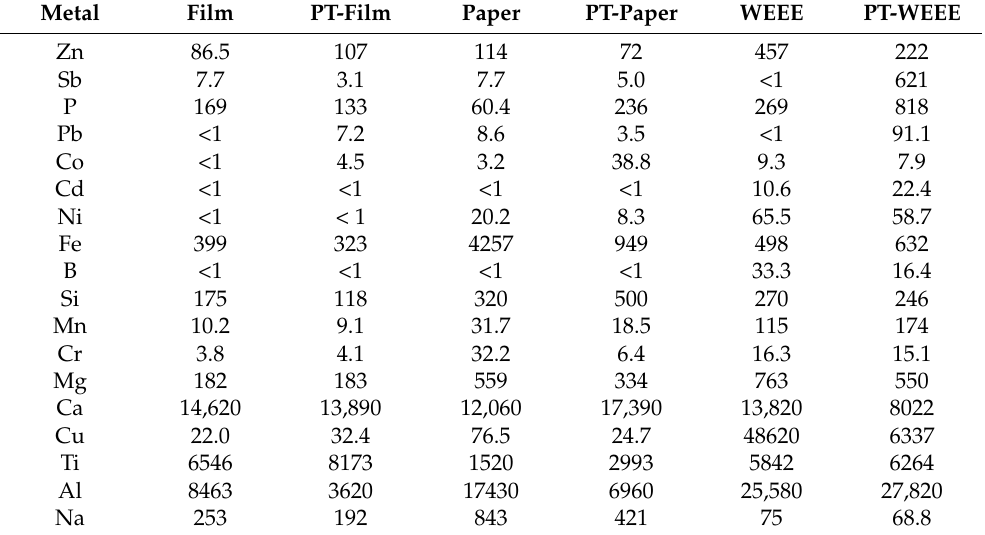
Table 5. Metal content in raw and pre-treated samples (ppm, as received).